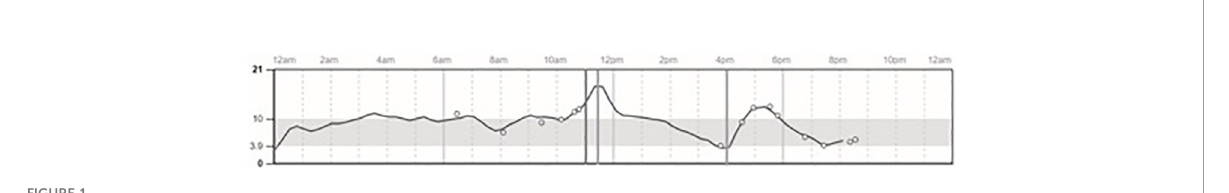
FIGURE 1 Libre trace during the Torbay 8 mile